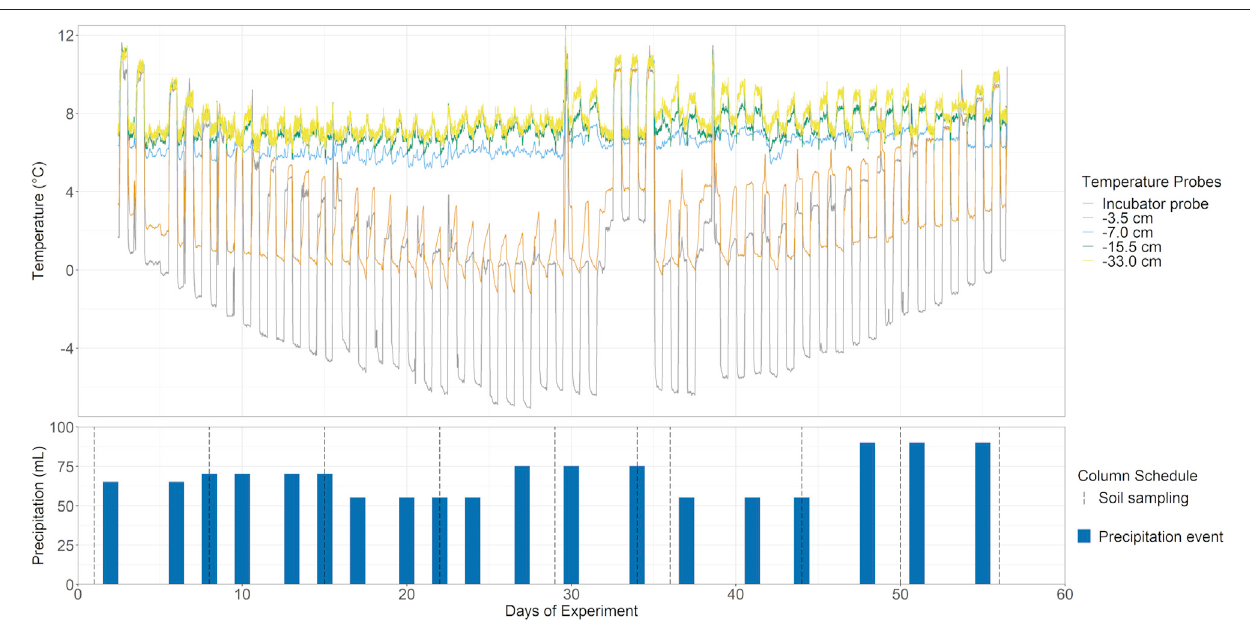
FIGURE2| Temperature andsimulatedclimatemodel.Top:Fivetemperatureprobesincludingambientincubatorairandvarioussoildepthswereusedtomonitor the simulated non-growing season, with additional premature mid-winter thaw, in the soil columns over 56 days. Insulation from the band-heater prevents FTC in all but the shallowest measured depth at − 3.5 cm. Bottom: Precipitation based on simulated climate data was added over the course of the experiment via sprinkler head and collected as leachate periodically. Soil sampling occurred approximately once a week, except for a higher resolution over the premature winter thaw (ten sampling points, grey dotted